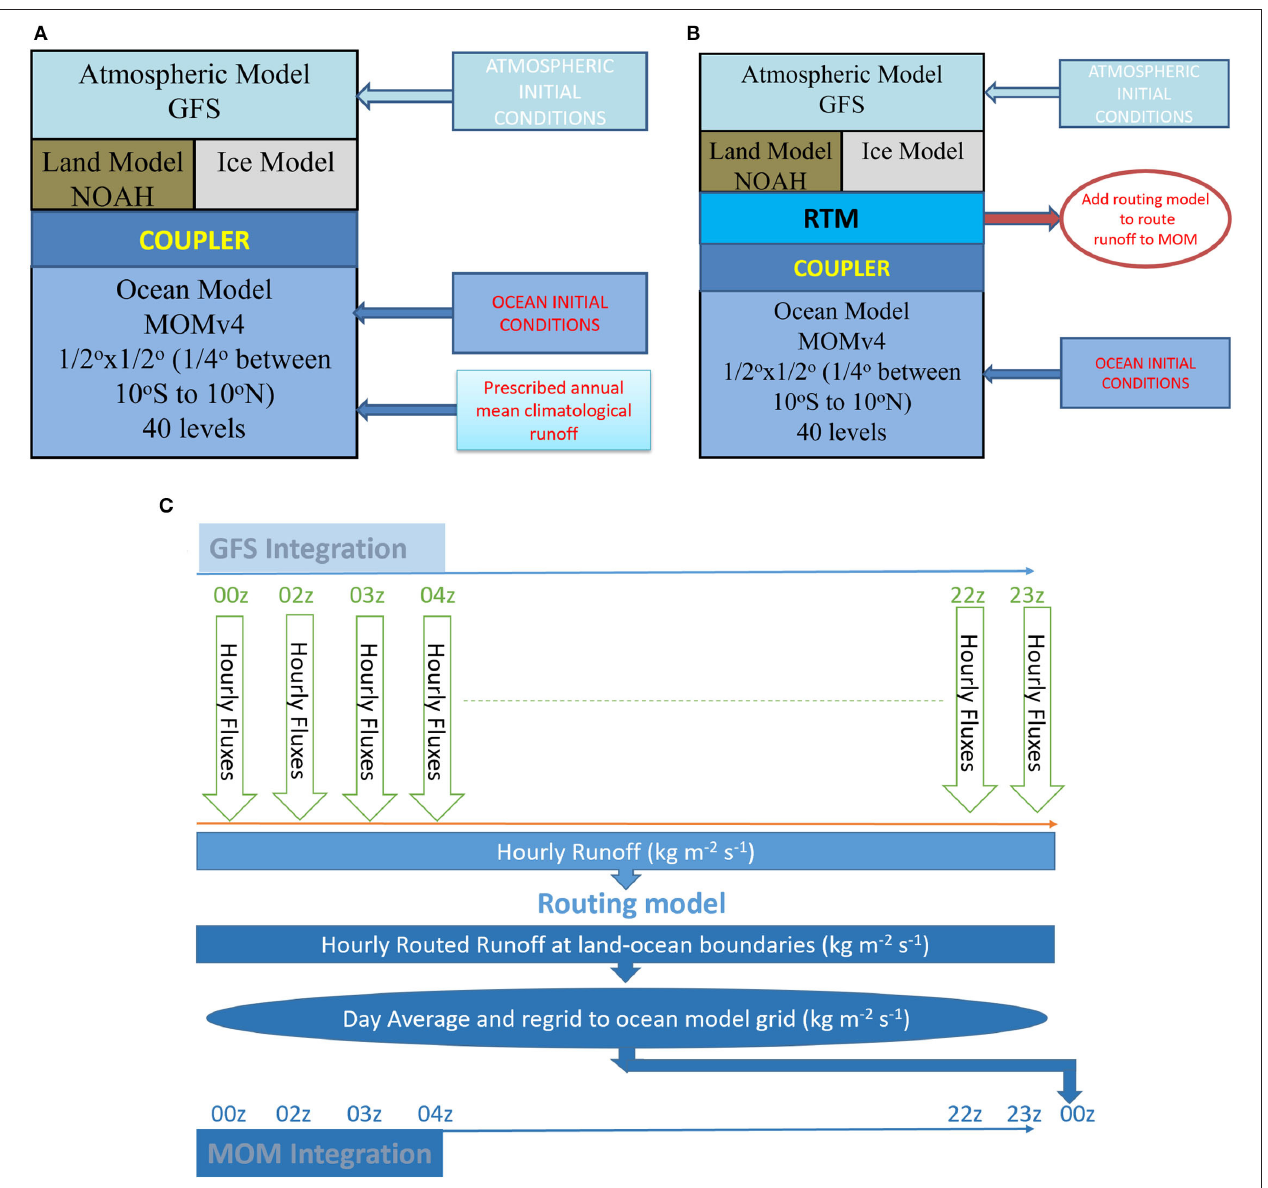
FIGURE 1 | (A) Illustration depicting the model components of the control (CTL) run. (B) Model components of the sensitivity (RIV) run with the routing model added and (C) schematic illustrating the coupling of the routing model to atmospheric and ocean model components. problems because of the formation of strong halocline and vertical advection noise across the front (Griffies et al., 2004, 2005; Yin et al., 2010; Hamman et al., 2017b). Therefore, the runoff in the RIV run is spread horizontally and is discharged into a thick layer [upper 40 m, as in Yin et al. (2010)]. The diffusivity in river mouths is enhanced vertically up to a depth of 40 m to parameterize unresolved scales (Benshila et al., 2014). The gray halos around the red markers in Figure 2A denote the horizontal area over which the runoff is spread. Horizontal spreading was implemented for all river outlets globally between 50 ◦ S and 50 ◦ N, wherever the river discharge was > 10 mm day − 1 , and for all outlets in the BoB. The prescribed runoff in CTL is pre-spread